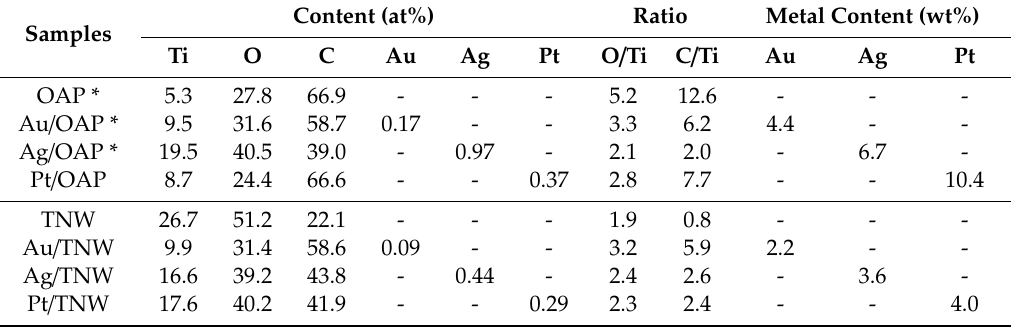
Table 1. Surface composition of modified samples determined by X-ray photoelectron spectroscopy (XPS) analysis of oxygen, titanium, carbon and metals for various samples.